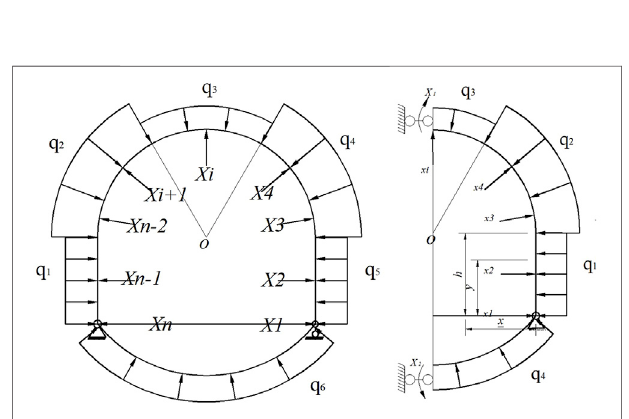
FIGURE10| Supporting structure mechanicsmodel ofthe double arch.